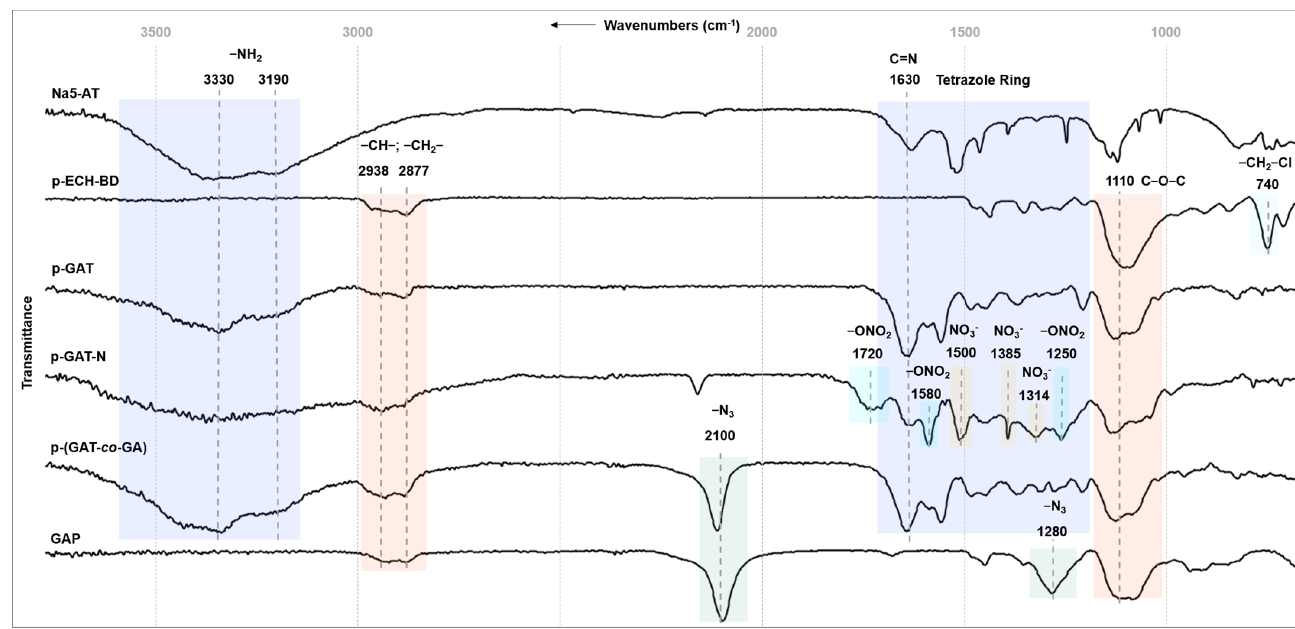
Figure 1. IR spectra of the starting Na5 ‐ AT and p ‐ ECH ‐ BD and of target polymers p ‐ GAT, p ‐ GAT ‐ N, p ‐ (GAT ‐ co ‐ GA) and GAP.